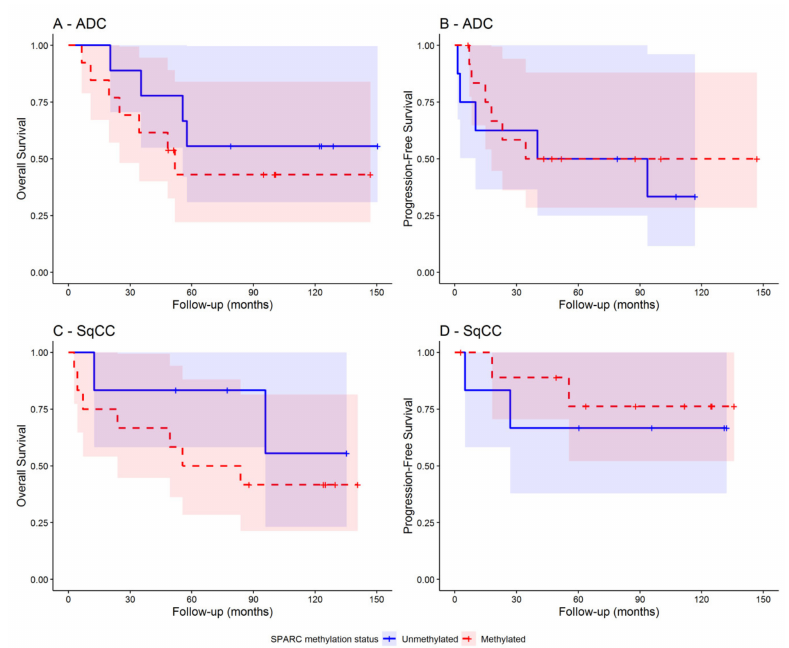
Figure 9. Kaplan-Meier curves showing the overall survival and disease progression-free survival in early tumor stage (I–II) NSCLC patients with ADC (panels A and B ) and SqCC (panels C and D ), respectively. Separate curves were reported for patients with methylated (red curve) and unmethylated (blue curve) SPARC gene promoter. The presence of SPARC methylation was defined for SPARC methylation levels ≥ 1.10.